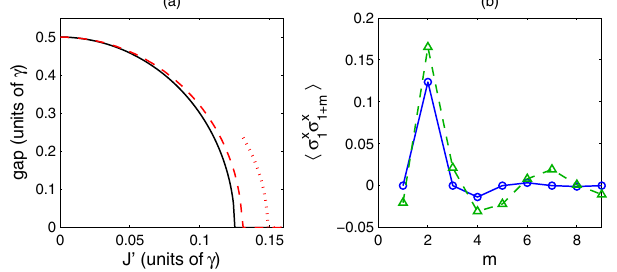
FIG. 9. Exact diagonalization of N ¼ 10 atoms with open boundary conditions and J ¼ 0 . (a) Gap (red dashed line) and second gap (red dotted line). The gap for N ¼ ∞ (solid black line) is from Eq. (10). (b) Correlations between the first atom and other atoms for J 0 ¼ 0 . 12 γ (blue solid line, circles) and J 0 ¼ 0 . 14 γ (green dashed line,